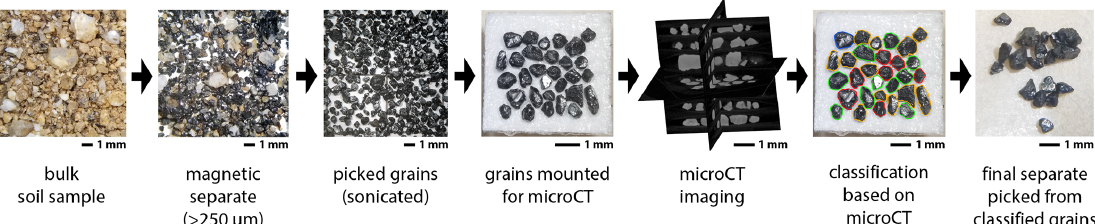
Figure 2. Sample processing workflow from bulk soil samples to final separates picked from microCT-analyzed grains. The microCT mounts of paper with double-sided tape are approximately 5mm in width and contain 20–50 grains each. Individual grains were classified as having no inclusions or containing bright, dark, or bright and dark inclusions according to microCT analysis (see Fig. 4), and grains for the final separates were picked from the mounts based on this classification. Scale bars are 1mm.